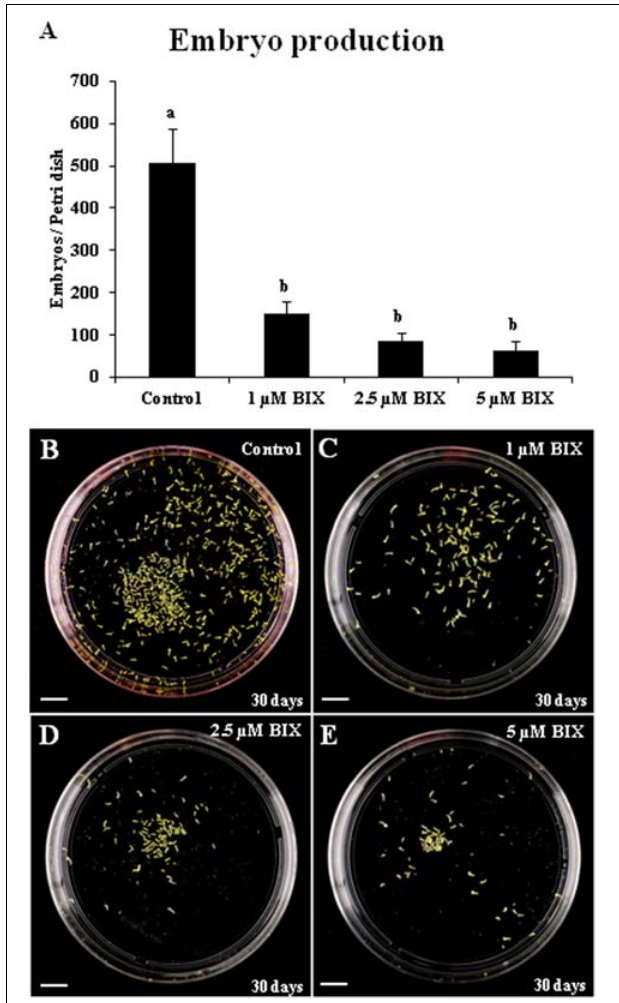
FIGURE 10 | Effects of BIX-01294 long treatments on microspore-derived embryo production of Brassica napus. (A) : Quantification of the embryo production in control and BIX-treated cultures at 1, 2.5, and 5 µ M concentrations. Columns represent mean values ( ± SEM) of the total number of embryos per Petri dish. Different letters on columns indicate significant differences according to ANOVA and Tukey’s tests at p < 0.05. (B–E) : Representative plates showing the microspore-derived embryos produced in control (B) and BIX-treated cultures at 1 µ M (C) , 2.5 µ M (D) and 5 µ M (E) concentrations, after 30 days. Bars represent 10